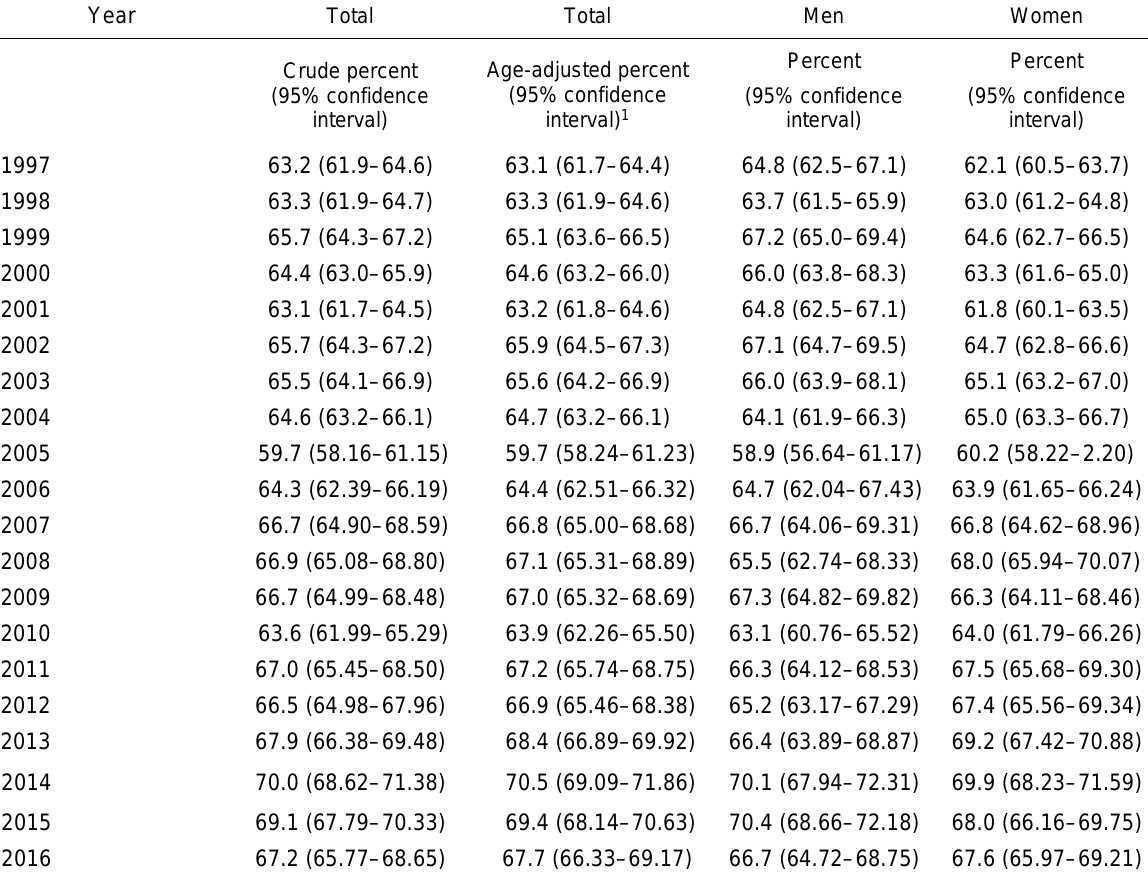
Table 4.1b. Percentage of adults aged 65 and over who received an influenza vaccination during the past 12 months, by sex: United States,